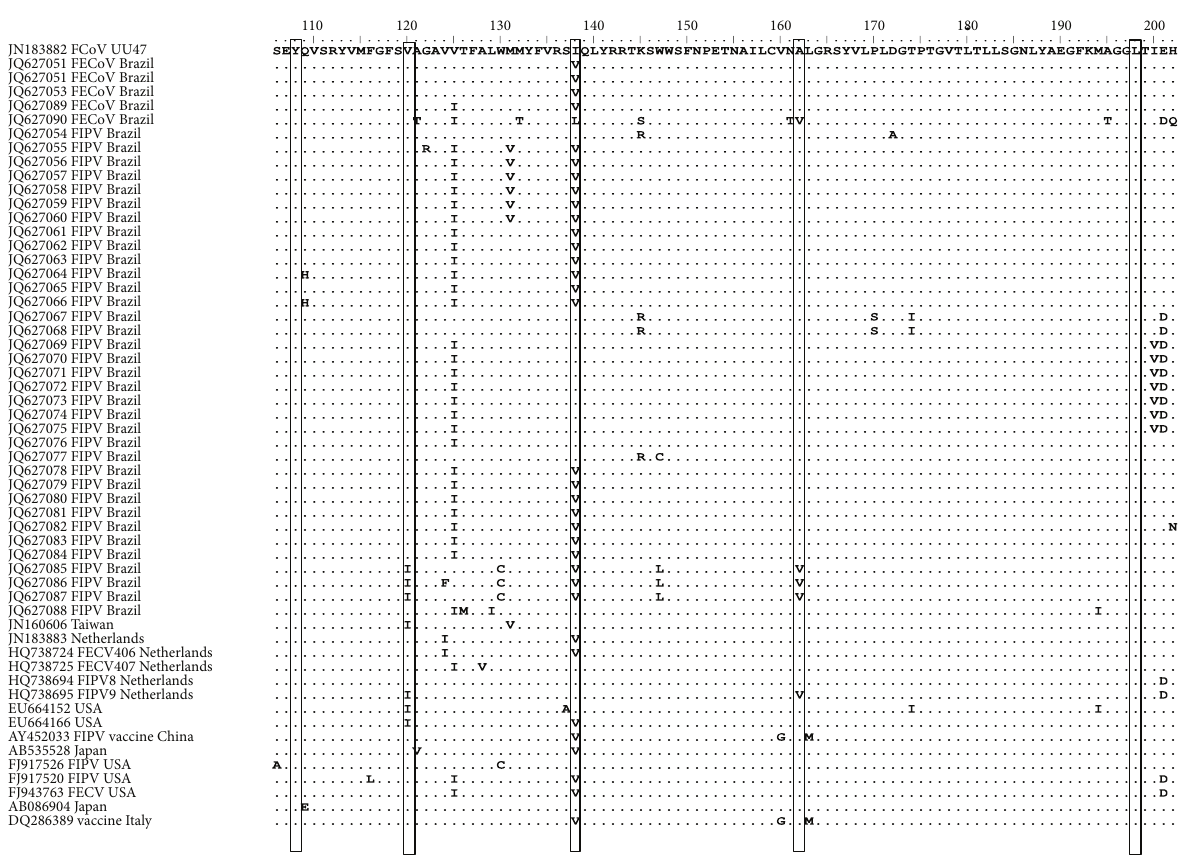
Figure 2: Alignment of the amino acid sequences of partial M proteins of the FCoVs compared with the feline coronavirus reference sequence (GenBank accession number JN183882) and other FCoV sequences from GenBank. The 5aa residues at positions 108, 120, 138, 162, and 198 suggested as potential diagnostic sites [5] are